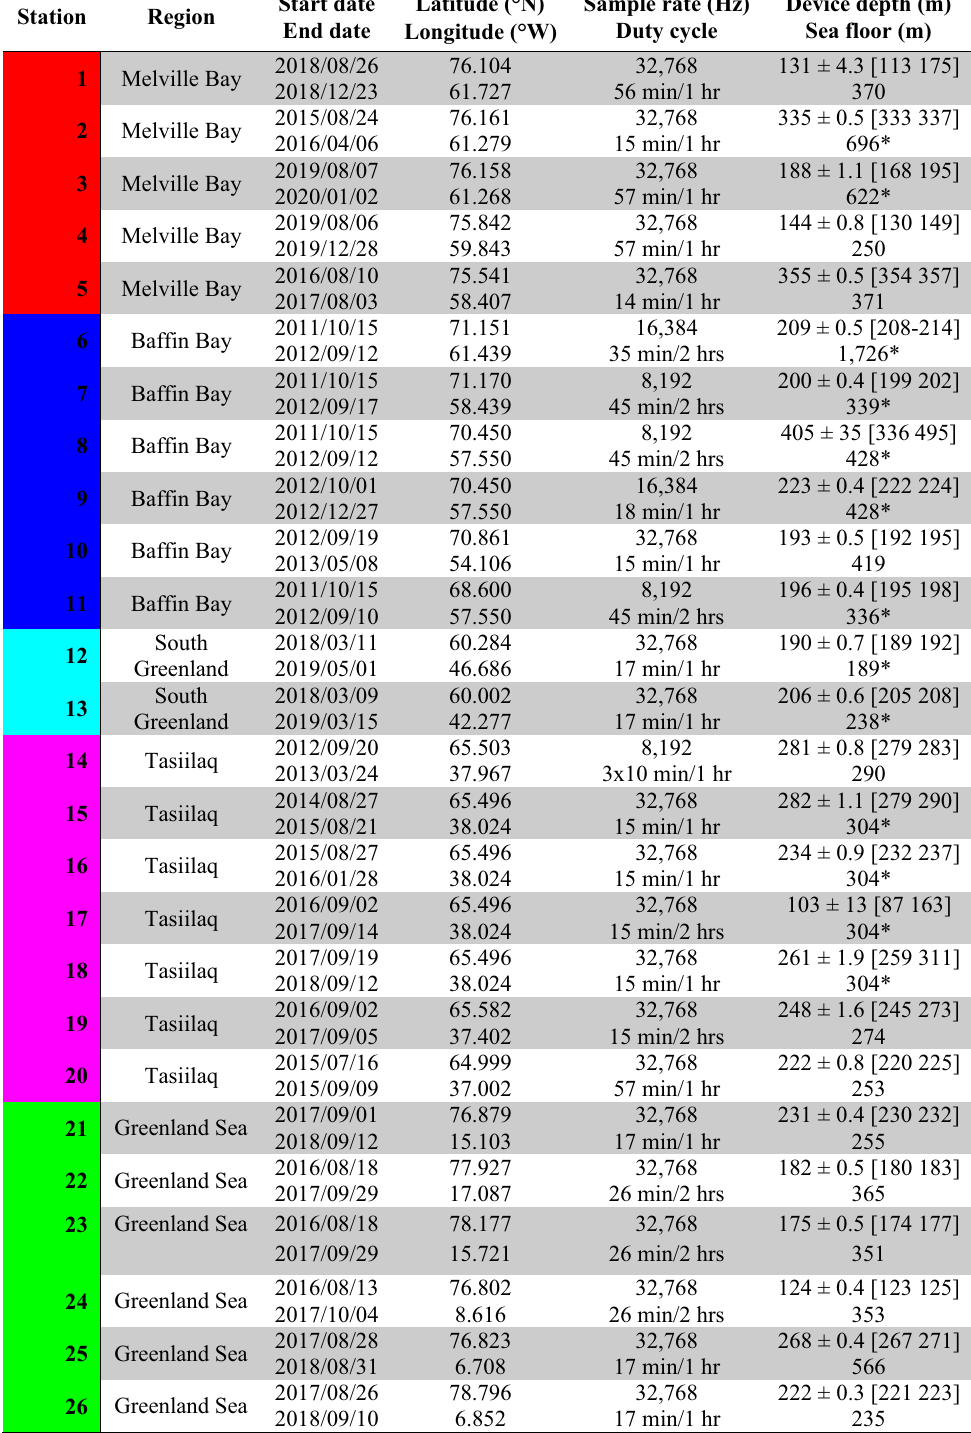
Table 1. Overview of the 26 deployments and field sites. Device depth is listed as mean ± SD with range in square brackets. (Note: Sea floor depths marked with asterisks (*) are not measured depths from this study, but stem from The International Bathymetric Chart of the Arctic Ocean Version 4.0 37 that has a grid resolution of 200 × 200